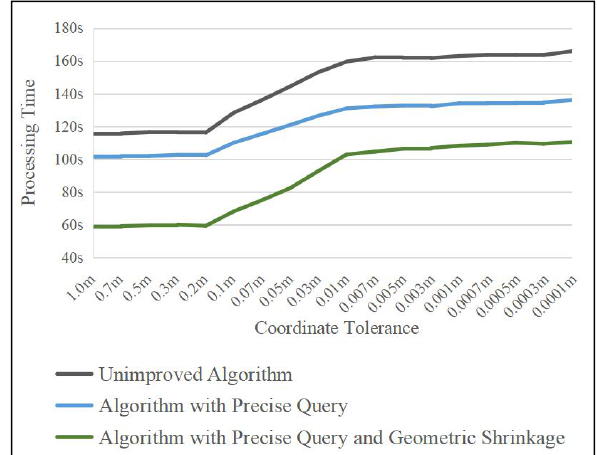
Figure 3. Average processing time comparison of farmland data